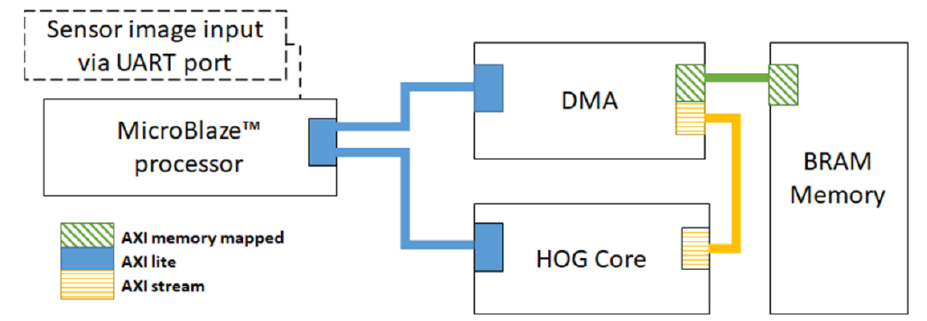
Figure 4. Block diagram of the proposed design and port connections.